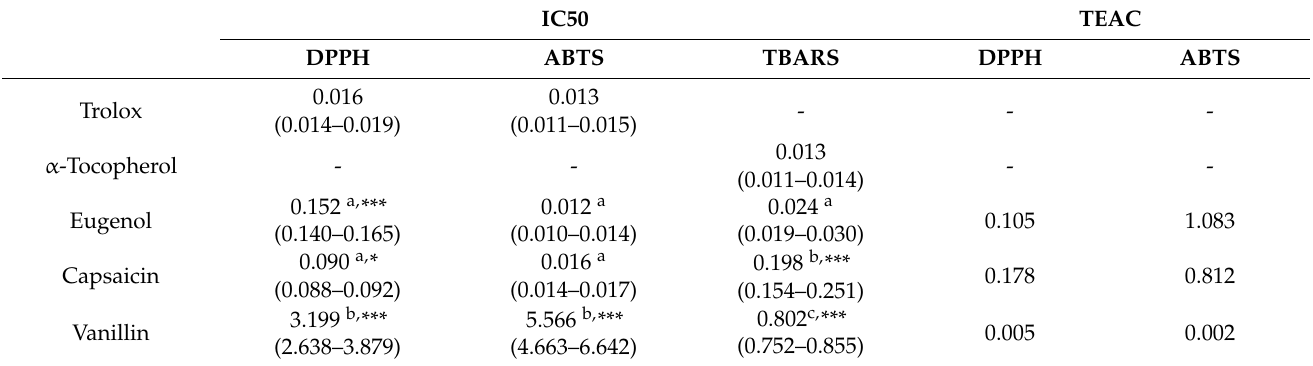
Table 4. IC50 and TEAC values. Median effective concentrations (IC50s, in mM) of phytochemicals able to scavenge the DPPH or ABTS radicals, or to inhibit the lipid peroxidation. * p < 0.05, *** p < 0.0001). Letters indicate the significant differences among phytochemicals for each assay (one-way ANOVA, Tukey’s multiple comparison test). All data come from three independent experiments. The 95% confidence limits are shown in parentheses.